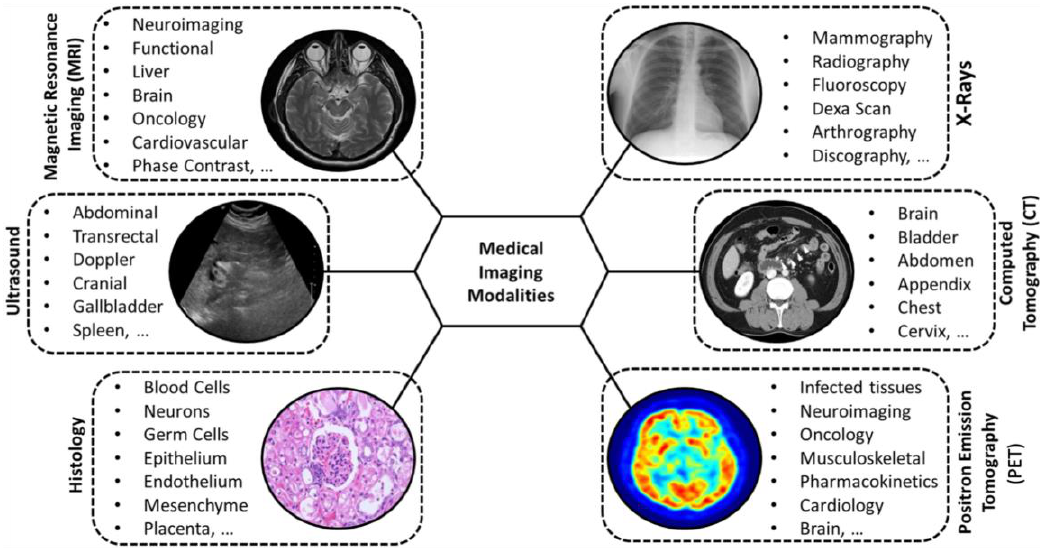
Figure 8. A typology of commonly used medical imaging modalities [64].